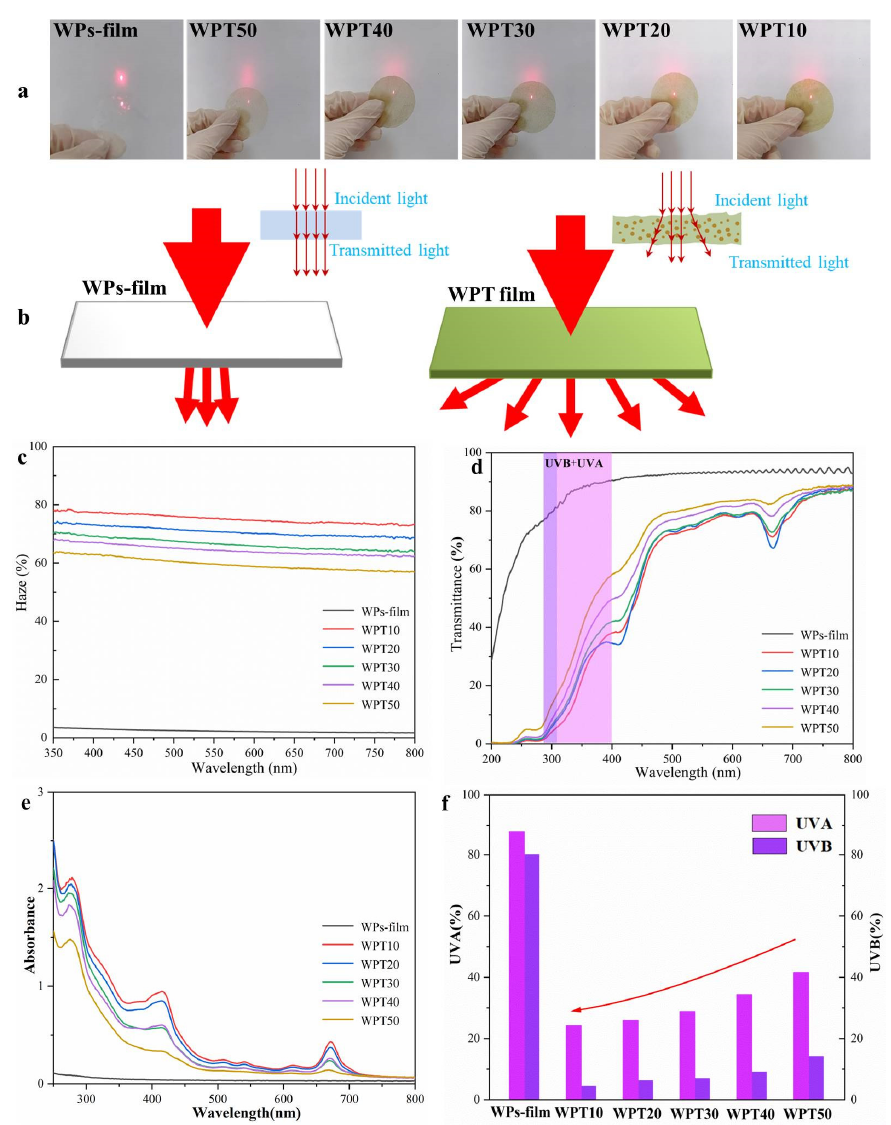
Figure 3. ( a ) The light scattering effect of the regenerated films; ( b ) the schematic comparison between the WPs-film and the green-tea-based composite film; ( c ) haze; ( d ) the transmittance; ( e ) absorbance; and ( f ) UVA and UVB of the regenerated films.